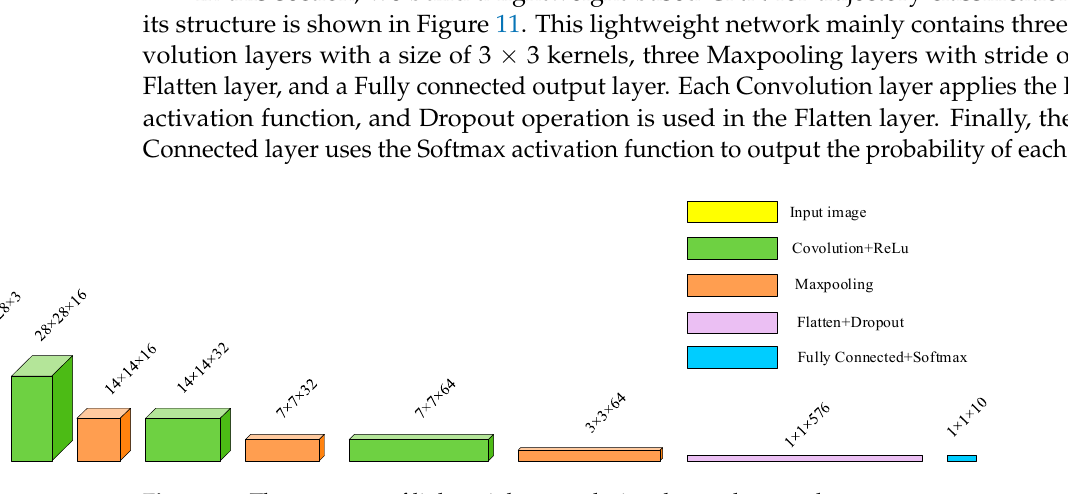
Figure 11. The structure of lightweight convolutional neural network.